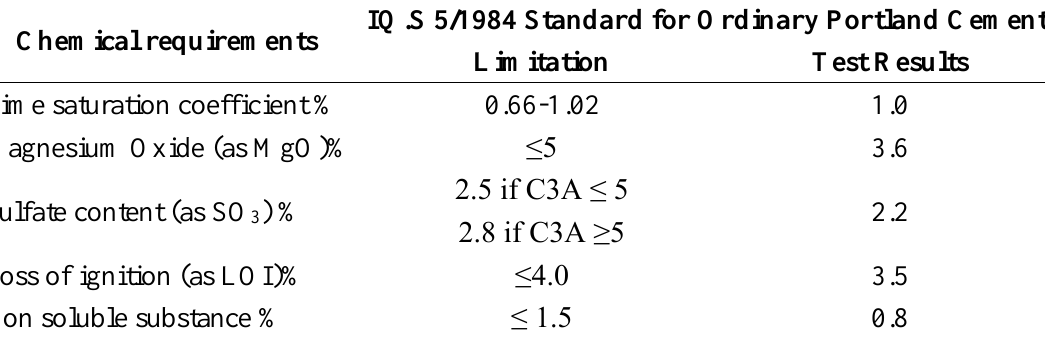
Table 1. Chemical properties of cement (OPC).